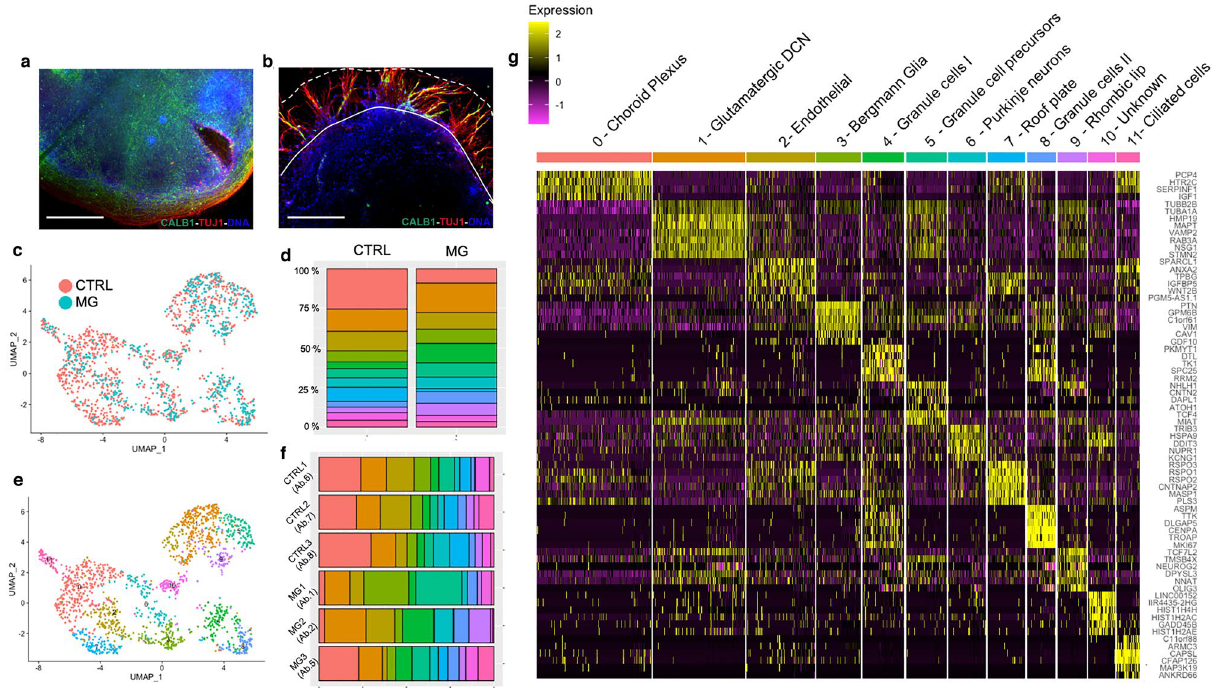
Figure 2. Characterisation of cerebellar organoids reveals population heterogeneity. ( a,b ) Representative images of unembedded (CTRL) organoid ( a ) and Matrigel (MG)-embedded organoid ( b ) prior to harvesting Lines demarcate the zone of Matrigel, which surrounds the organoid. Organoids immunostained for Calbindin (green) and TUJ1 (red). Nuclei were stained with Hoechst (blue). Scale bars are 500 μm. ( c ) UMAP plot after canonical correlation analysis (CCA) illustrates representation of cells across treatment conditions (pink—control, teal—MG treatment from day 21). ( d ) Visual depiction of organoid heterogeneity, colored by population, shows representation of cell types across treatment groups. Left: control (CTRL), right: MG-embedded. ( e ) UMAP plot of all cells showing 12 populations following separation after CCA at resolution 0.8. ( f ) Visual depiction of cohort heterogeneity, per individually hash-labelled organoid, colored by population, shows representation of cell types across individually barcoded organoids. Further information is given in Supplementary Figure S5. ( g ) Heatmap depicting the top six marker genes per cell population across all groups, filtered by log fold-change values. Heatmap made with Seurat